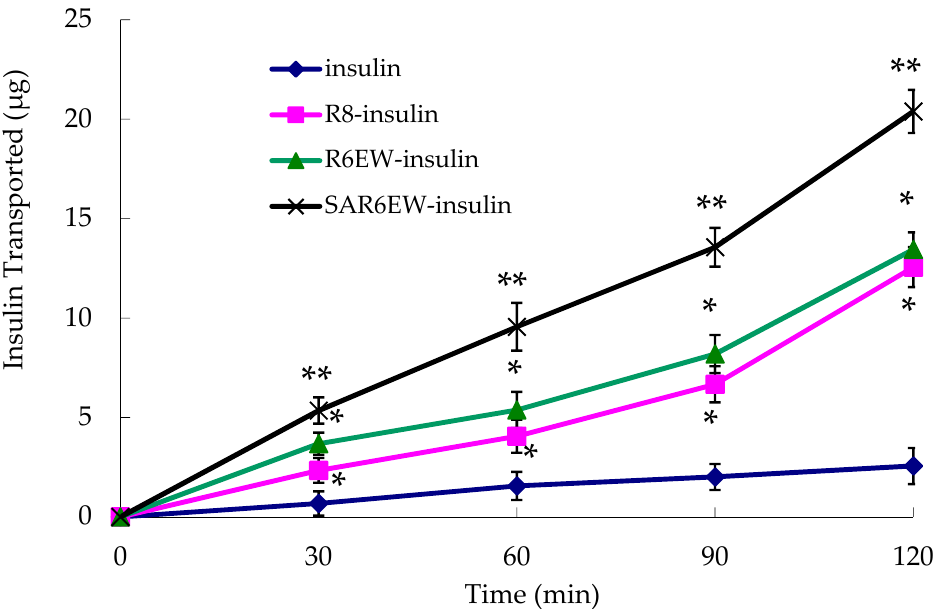
Figure 5. Amount of insulin transported across Caco-2 cell monolayer during the permeation experiments (mean ± SD, N = 3, *: p < 0.05, **: p < 0.01 vs. control).